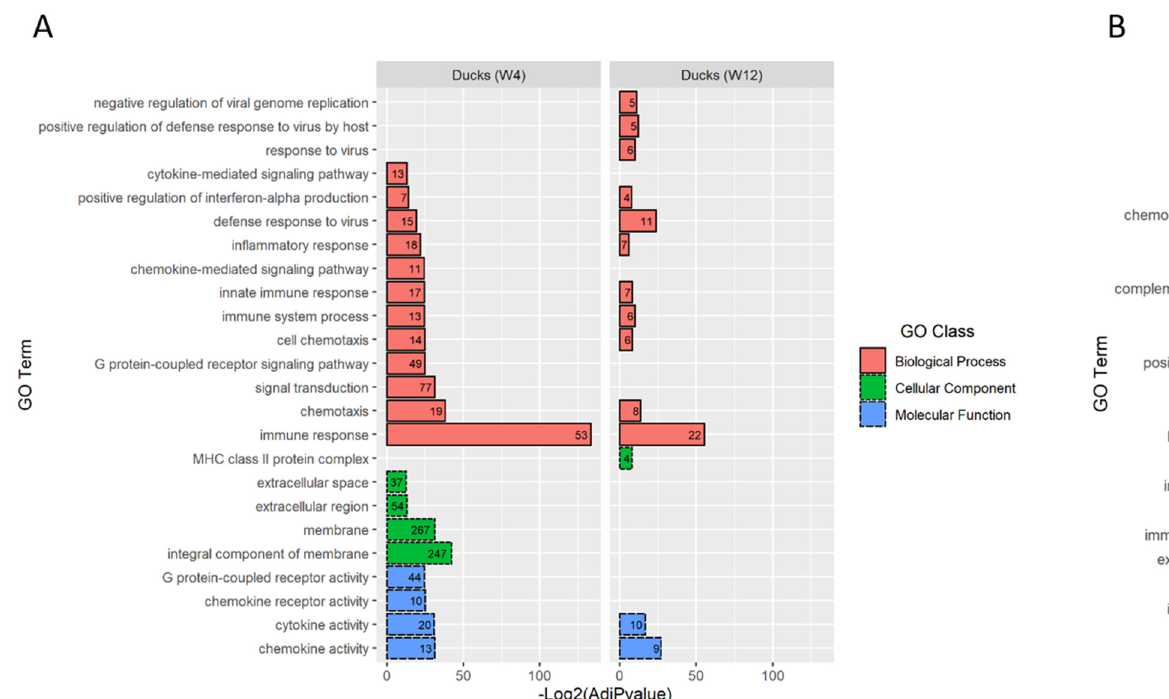
Figure 4. Gene ontology (GO) analysis of Muscovy duck and chicken brains infected with ABBV − 1 at 4 and 12 weeks post-infection (wpi). In ( A ), the 20 highest-ranked (out of 59) and 14 (out of 14) enriched GO terms are shown for the Muscovy ducks sampled at 4 wpi (left graph) and 12 wpi (right graph), respectively. In ( B ), the 20 highest-ranked (out of 107) significantly enriched GO terms are shown for the chickens sampled at 12 wpi. Chicken brains sampled at 4 wpi did not produce any significantly enriched GO terms. The significance of the GO terms’ enrichment is represented as − log 2 of the adjusted p -values on the x -axis. The GO categories are labeled and grouped by colors ( y -axis): red bars represent biological processes, green bars represent cellular components, and blue bars represent molecular function. The numbers inside the bars represent the numbers of differentially expressed genes per GO term.